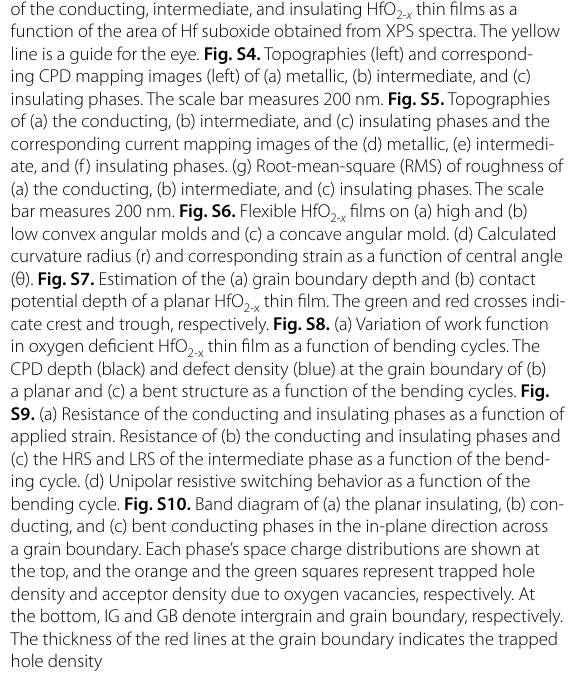
of the conducting, intermediate, and insulating HfO 2- x thin films as a function of the area of Hf suboxide obtained from XPS spectra. The yellow line is a guide for the eye. Fig. S4. Topographies (left) and correspond- ing CPD mapping images (left) of (a) metallic, (b) intermediate, and (c) insulating phases. The scale bar measures 200 nm. Fig. S5. Topographies of (a) the conducting, (b) intermediate, and (c) insulating phases and the corresponding current mapping images of the (d) metallic, (e) intermedi- ate, and (f) insulating phases. (g) Root-mean-square (RMS) of roughness of (a) the conducting, (b) intermediate, and (c) insulating phases. The scale bar measures 200 nm. Fig. S6. Flexible HfO 2- x films on (a) high and (b) low convex angular molds and (c) a concave angular mold. (d) Calculated curvature radius (r) and corresponding strain as a function of central angle (θ). Fig. S7. Estimation of the (a) grain boundary depth and (b) contact potential depth of a planar HfO 2-x thin film. The green and red crosses indi- cate crest and trough, respectively. Fig. S8. (a) Variation of work function in oxygen deficient HfO 2-x thin film as a function of bending cycles. The CPD depth (black) and defect density (blue) at the grain boundary of (b) a planar and (c) a bent structure as a function of the bending cycles. Fig. S9. (a) Resistance of the conducting and insulating phases as a function of applied strain. Resistance of (b) the conducting and insulating phases and (c) the HRS and LRS of the intermediate phase as a function of the bend- ing cycle. (d) Unipolar resistive switching behavior as a function of the bending cycle. Fig. S10. Band diagram of (a) the planar insulating, (b) con- ducting, and (c) bent conducting phases in the in-plane direction across a grain boundary. Each phase’s space charge distributions are shown at the top, and the orange and the green squares represent trapped hole density and acceptor density due to oxygen vacancies, respectively. At the bottom, IG and GB denote intergrain and grain boundary, respectively. The thickness of the red lines at the grain boundary indicates the trapped hole density Acknowledgements Not